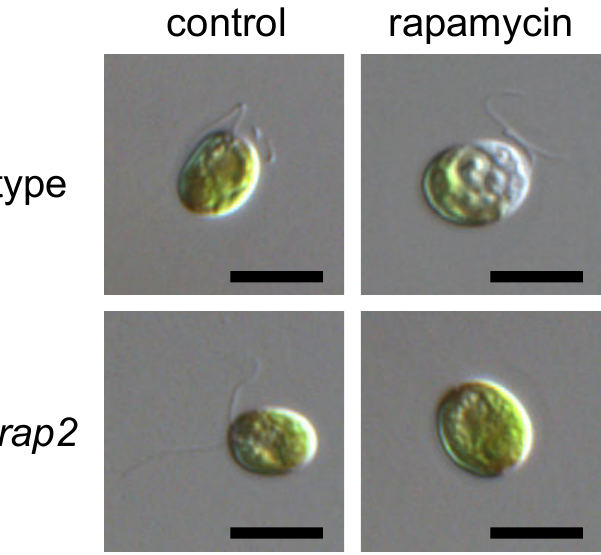
Figure 1. Sensitivity of Chlamydomonas cells to rapamycin. Nomarski images of wild-type and rap2 mutant cells treated with 500 nM rapamycin for 24 h. Bleaching and pronounced vacuolization is observed in wild-type treated cells but not in the rapamycin-resistant mutant rap2 , which lacks